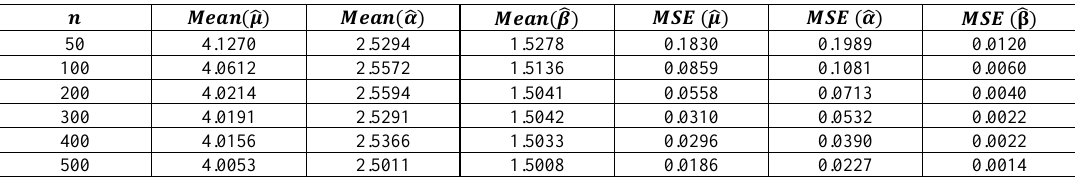
Table 1. Empirical mean and empirical mean squared error (MSE) of parameters estimates for 𝜇 = 4 , 𝛼 = 2.5 , and 𝛽 = 1.5